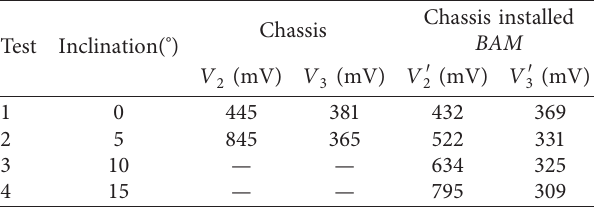
Figure 16: Pressure test of (a) chassis and (b) chassis installed BAM . Table 4: Test conditions and